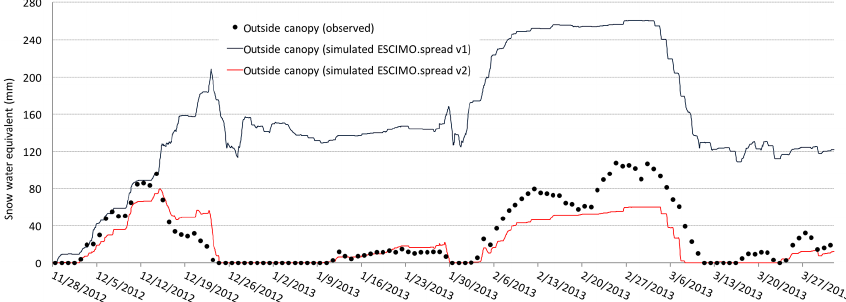
Figure 11. Simulated and observed snow water equivalent outside the forest canopy for the winter period 2012/13 at site Vordersteinwald. The blue and red lines represent the results achieved with the previous (v1) and newly developed (v2) versions of the ESCIMO.spread model,